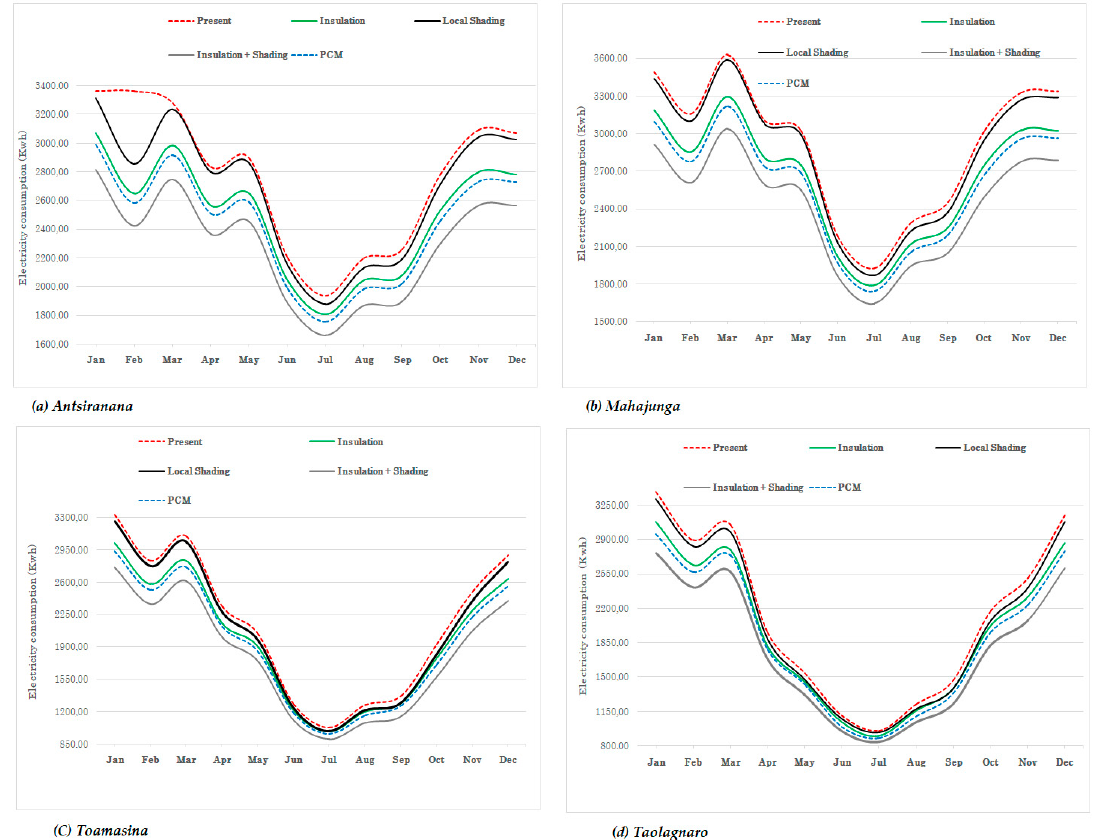
Figure 7. Variation in electricity consumption in the four cities selected after applying passive strategies. Table 5. Electricity consumption (kWh/m 2 ).